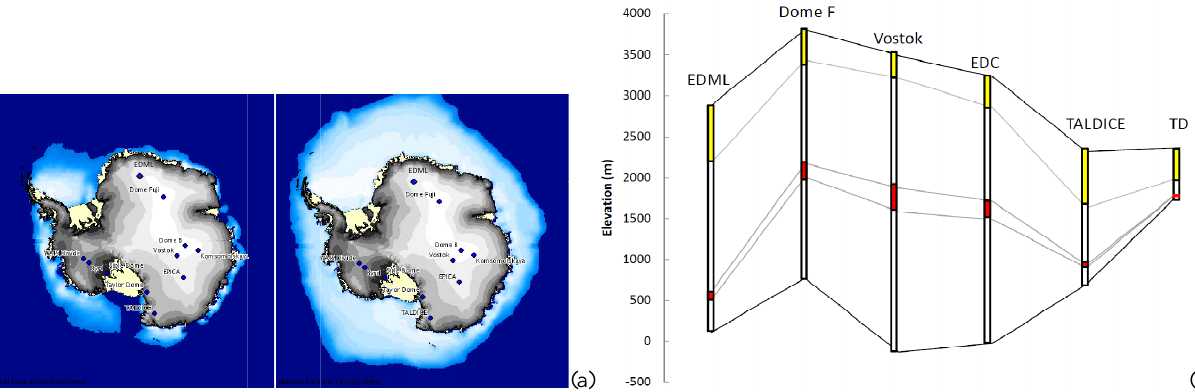
Figure 1b. Surface elevation (upper line), ice core depths (vertical rectangles) and position of the Holocene (yellow rectangles) and Last Interglacial (red rectangles) periods (as defined in Table 2, using EDC3 age scale for all records with the exception of TD). Note that the horizontal axis is not proportional to distance. The distance from EPICA Dome C to Vostok is 560km, and from Vostok to Dome F ∼ 1500km.